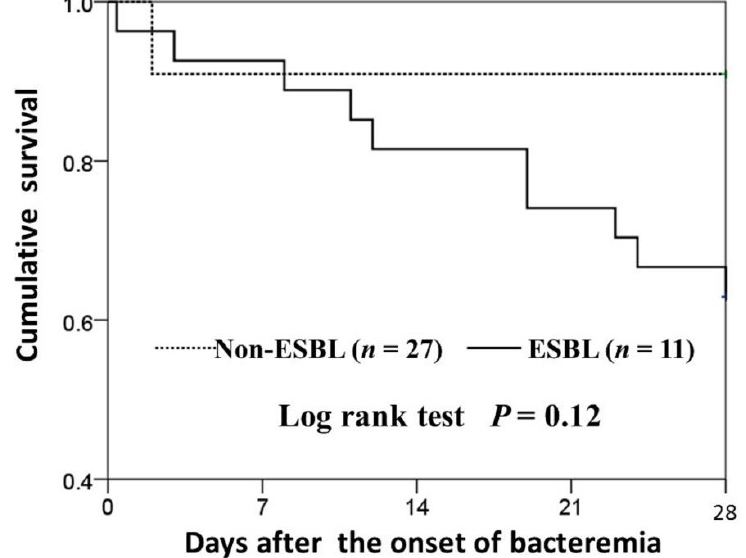
Figure 3. Survival curves of the cases of community-onset bacteremia due to levofloxacin-resistant ST131 Escherichia coli , categorized by the presence or absence of ESBL production.